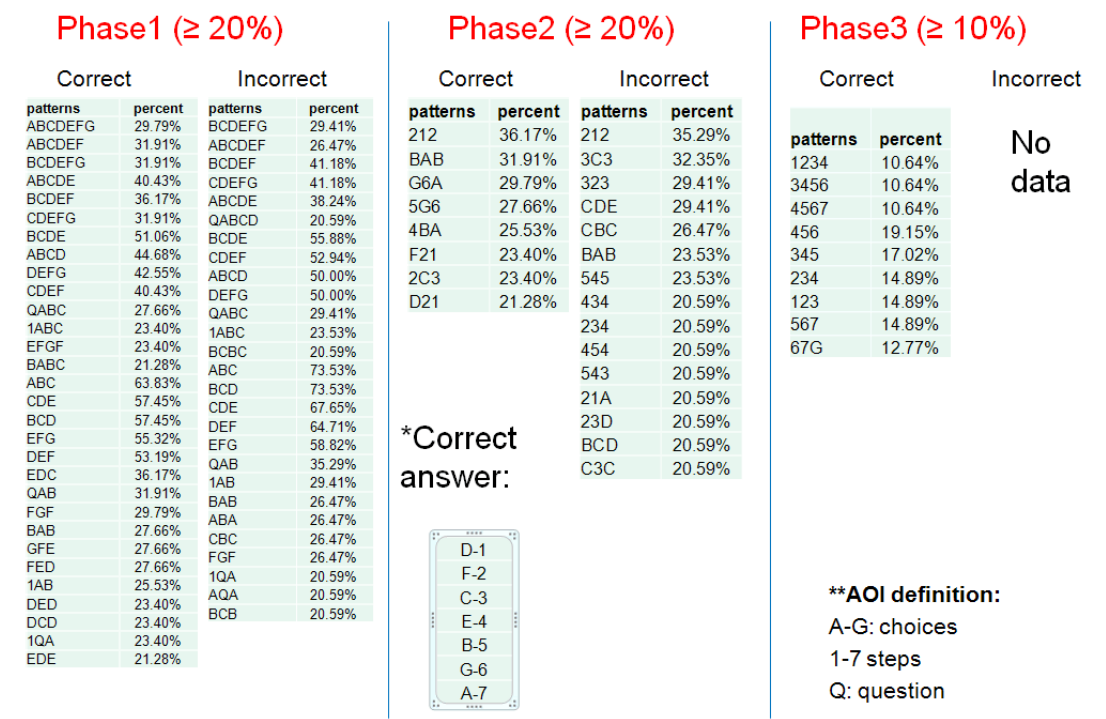
Figure 5. Scanpath patterns in each phase of the third ordering problem for students who solved the problem correctly and incorrectly. For each group (correct or incorrect), column 1 contains the scanpath pattern and column 2 contains the percentage of the occurrence of pattern, i.e., the ratio of the number of participant who had a pattern to the total number of participants in a group. The definition of AOIs is listed at the bottom of Phase 3, and the correct order of the choices (answer key) in Problem 3 is listed at the bottom of Phase 2. For example, choice D should be placed in step box 1, choice F in step box 2, choice C in step box 3,